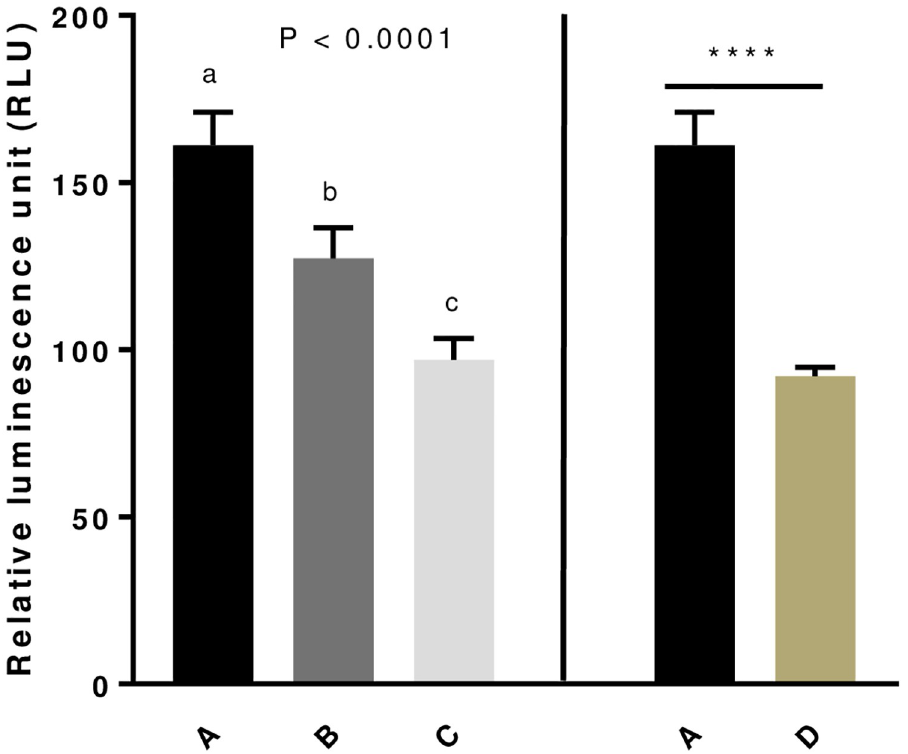
Fig 5. Level of Reactive Oxygen Species (ROS, H202) in egg yolk of broiler hens fed with different concentrations of GSE dietary supplementation. ROS level (H202) was assessed from 1 g of each egg yolk using Ros-Glo assay. Ten egg yolks were analysed for each group of animals. A: animals fed with control diet without GSE supplementation, B and C: animals supplemented with GSE at 0.5% and 1% of the total diet composition, respectively, starting at 4 week- old until 40 week-old (experiment 1), and D: supplementation at 1% of the total diet composition starting at the hatching until 40 week-old (experiment 2). Results are presented as lsmeans ± S.E.M. P values and different individual letters indicate a significant effect of the diet between A, B and C groups (experiment 1) or between A and D groups (experiment 2). P value was considered as significant if P < 0.05. ���� P <